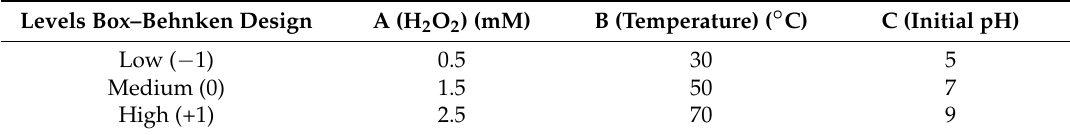
Table 9. Experimental design levels with three